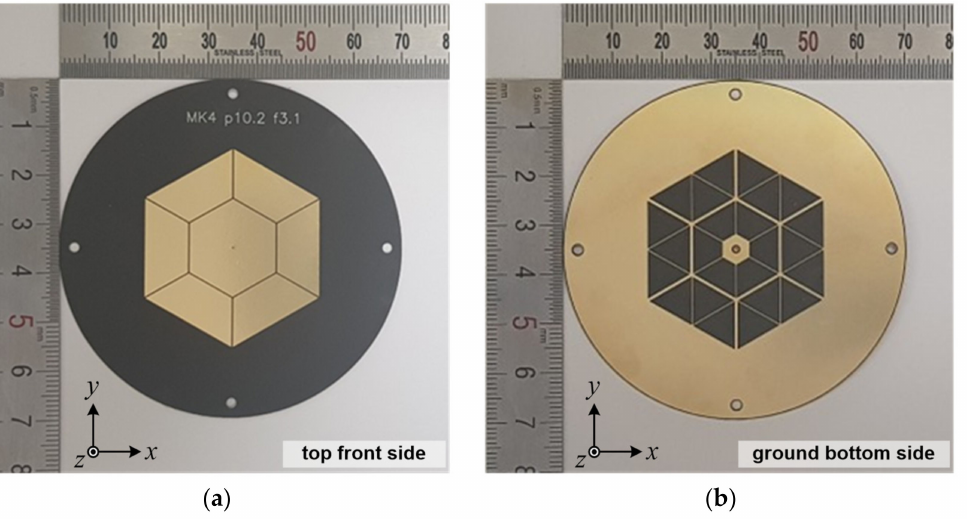
Figure 5. Photos of the implemented antenna: ( a ) top front side and ( b ) ground bottom side.